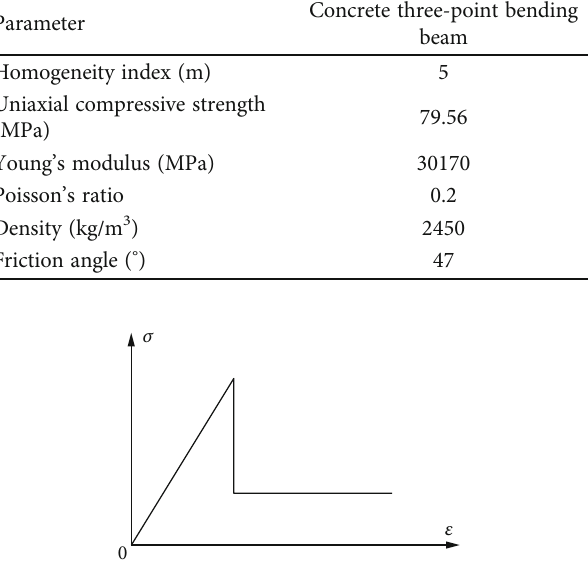
Figure 2: Elastic-brittle constitutive relationship of concrete three- point bending